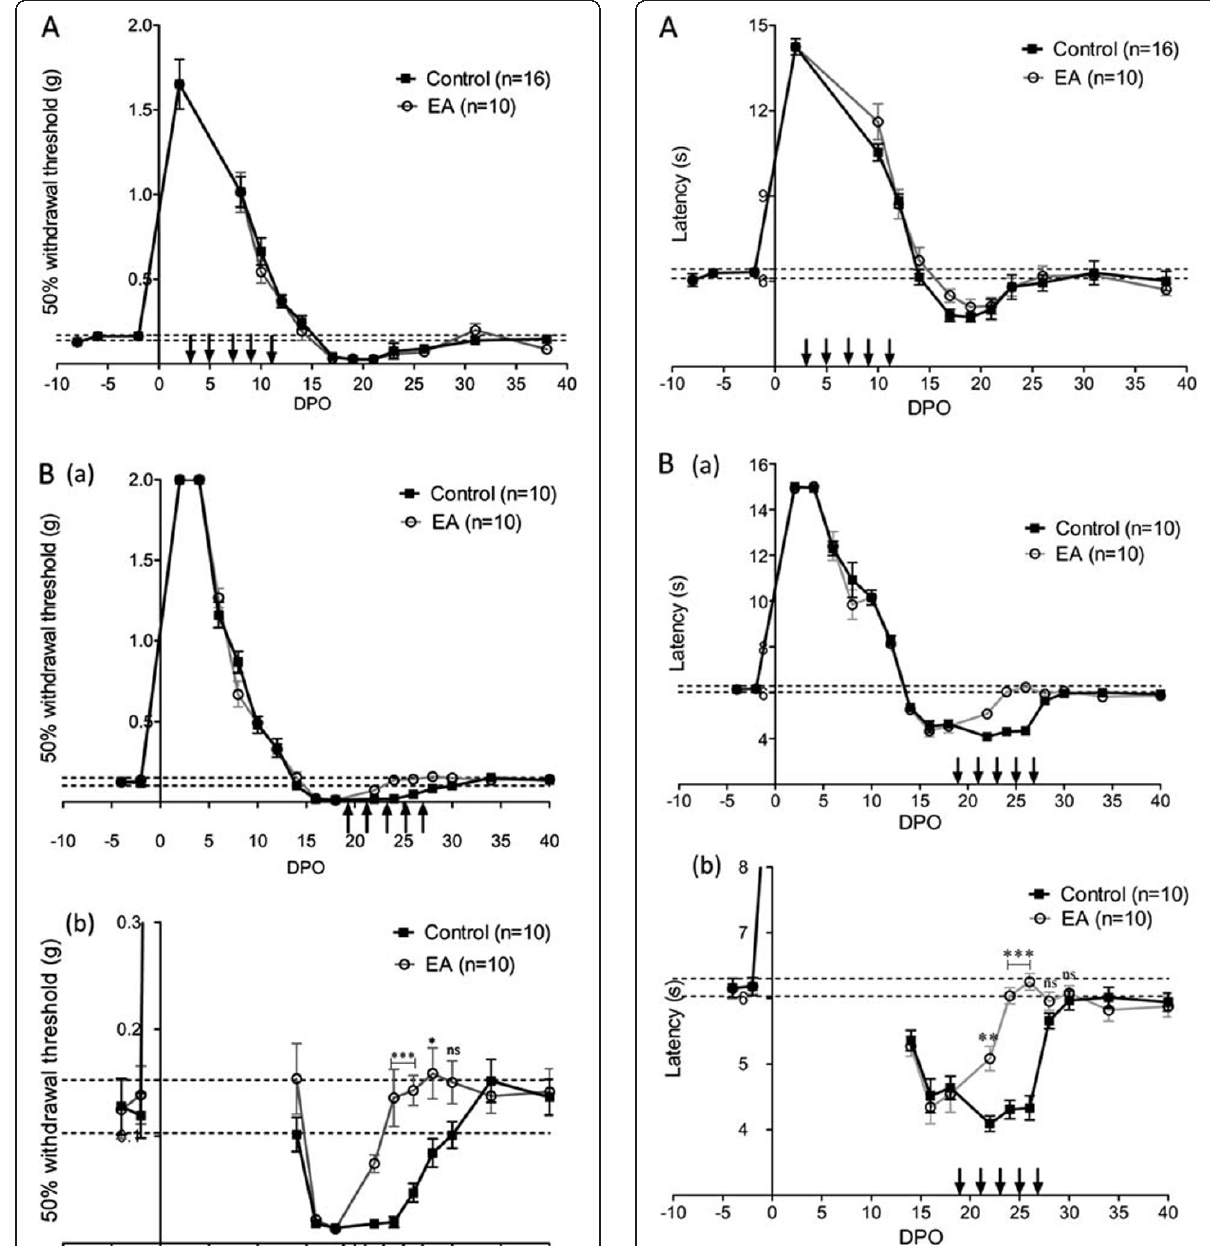
Figure 2 Analysis of heat sensitivity recovery. ( A ) Time for recovery of sensitivity to a heat stimulus. The latency of paw withdrawal was measured before and after left sciatic nerve crush injury. Vertical arrows indicate electro-acupuncture (EA) application (group 1). ( B ) ( a ) Effects of electro-acupuncture applied at the moment of pain development (19 to 27 DPO) (group 2). In ( b ) enlarged view of the period of pain-related symptoms. * p<0.05, ** p<0.01 assessed the global mouse gait by analysing the percentage of normal runs from just after sciatic nerve crush up until full recovery. Figure 3 shows that 1 week after the crush, roughly 60% of control animals displayed normal runs (see